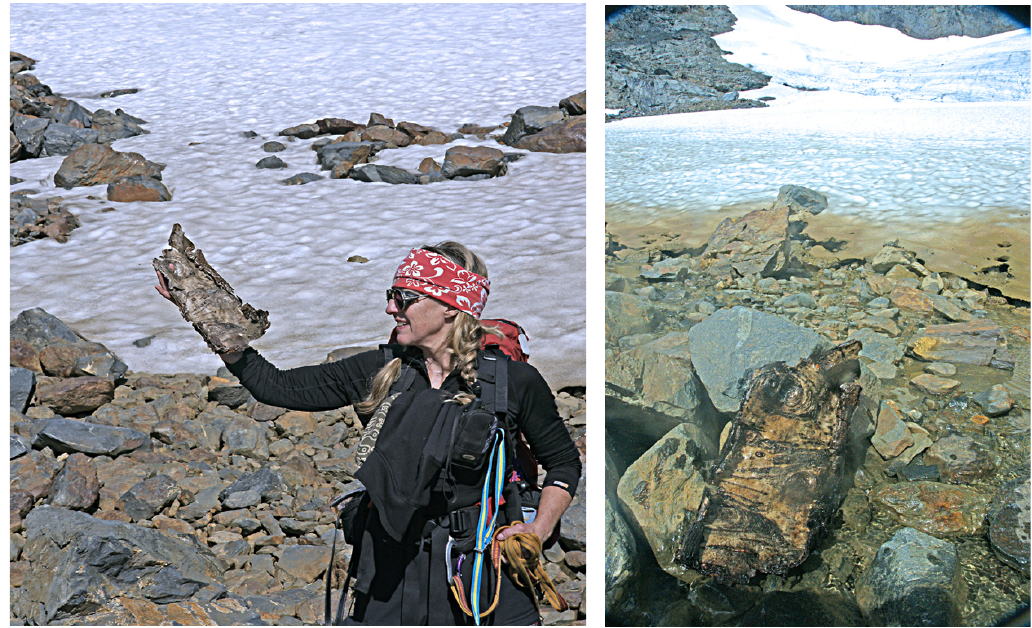
Figure 29: Ekorrglaciären (5). Left. A chunk of bark from a fairly stout birch tree, exposed in a drainage strem. 9020 cal. yr BP (Beta-250921). Right. Close-up